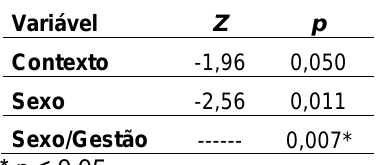
Tabela 2. Interação das variáveis “Contexto“ e “Sexo“ com escolha do motivo para a prática